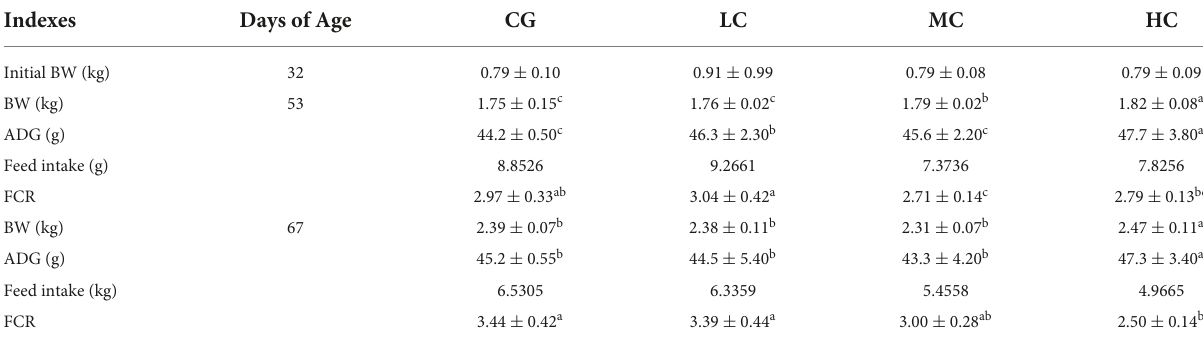
Acid, and D-Biotin were negatively correlated with BW and